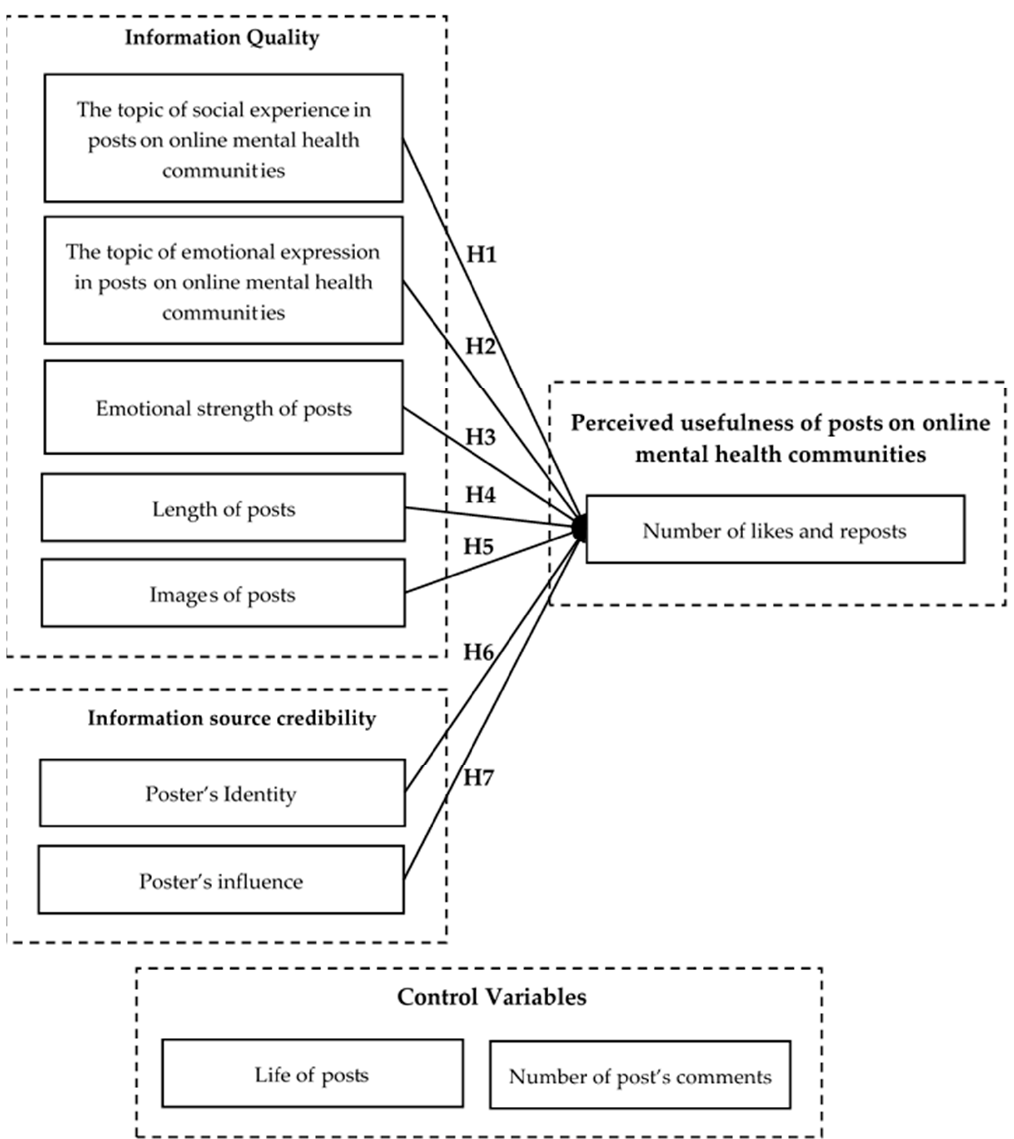
Figure 1. The research model of factors influencing the number of likes and reposts in online mental health communities that a post receives.